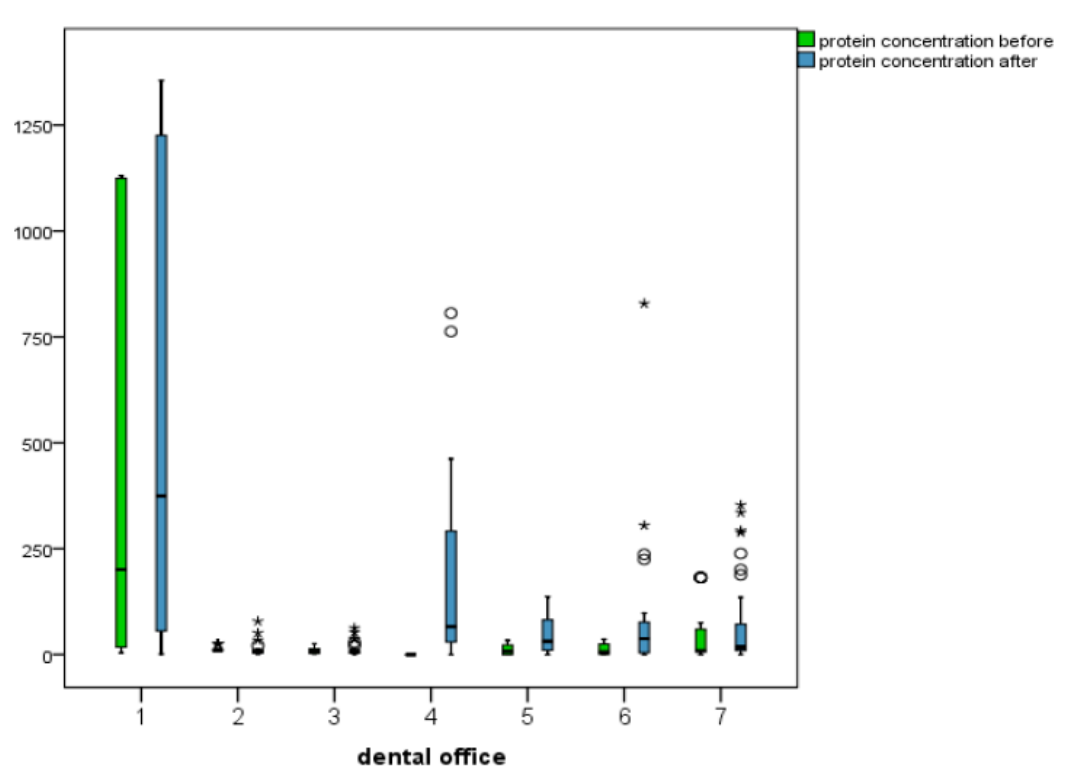
5.Figure 3. Protein concentrations before and after treatment for each dental office (* and ◦ for outliers). 3.2. Final Statistics—Combined Influence of Parameters on Protein Concentration after Treatment and Difference (Increase or